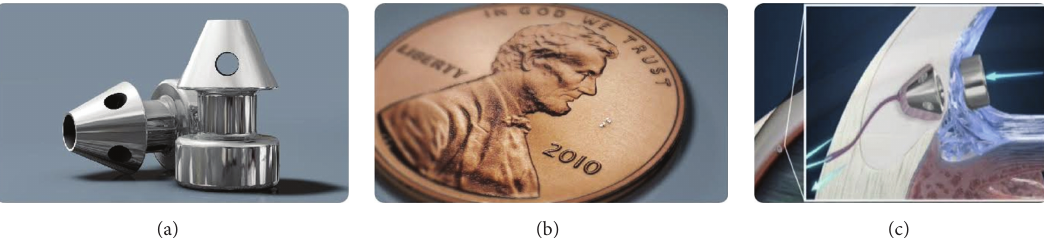
Figure 2: Illustration of the second-generation iStent inject (a); size comparison of the iStent inject (b); schematic illustration of iStent inject placement in trabecular meshwork (c). ((a)–(c), courtesy of Glaukos Corporation).